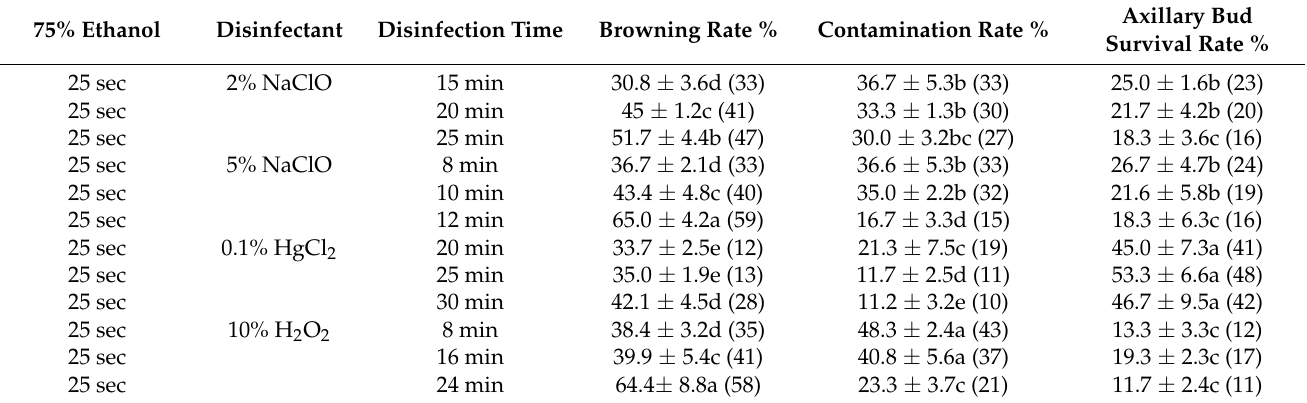
Table 1. Effects of disinfectant types and times on disinfection of stem with bud of D. lotus